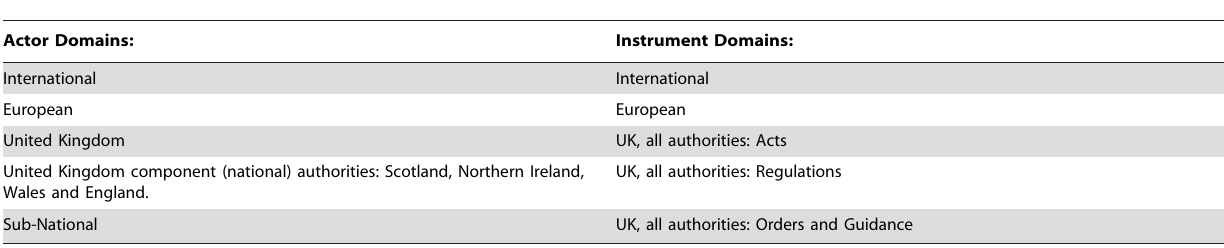
Table 2. Definitions of policy actor and policy instrument domains.